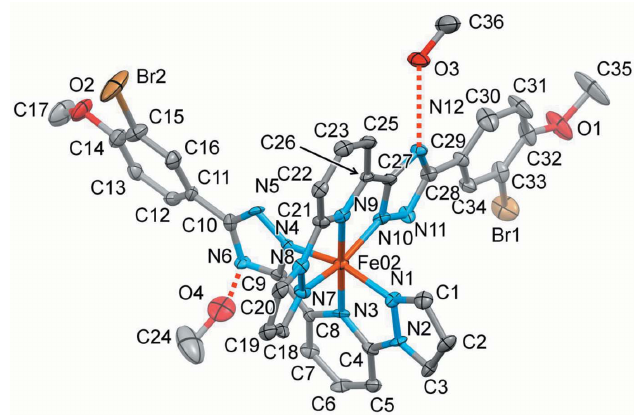
Figure 1 The molecular structure of the title compound with displacement ellipsoids drawn at the 50% probability level. H atoms have been omitted for clarity. Hydrogen bonds are indicated by dashed lines.